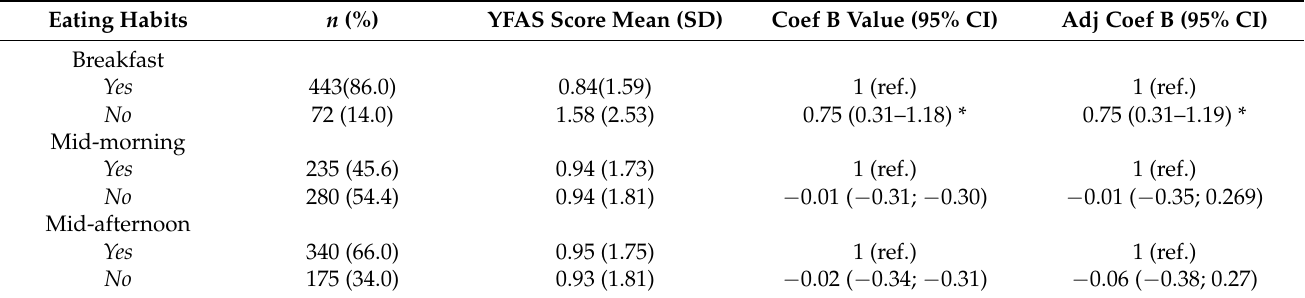
Table 3. Food addiction and food consumption unadjusted and adjusted for sex, age, and